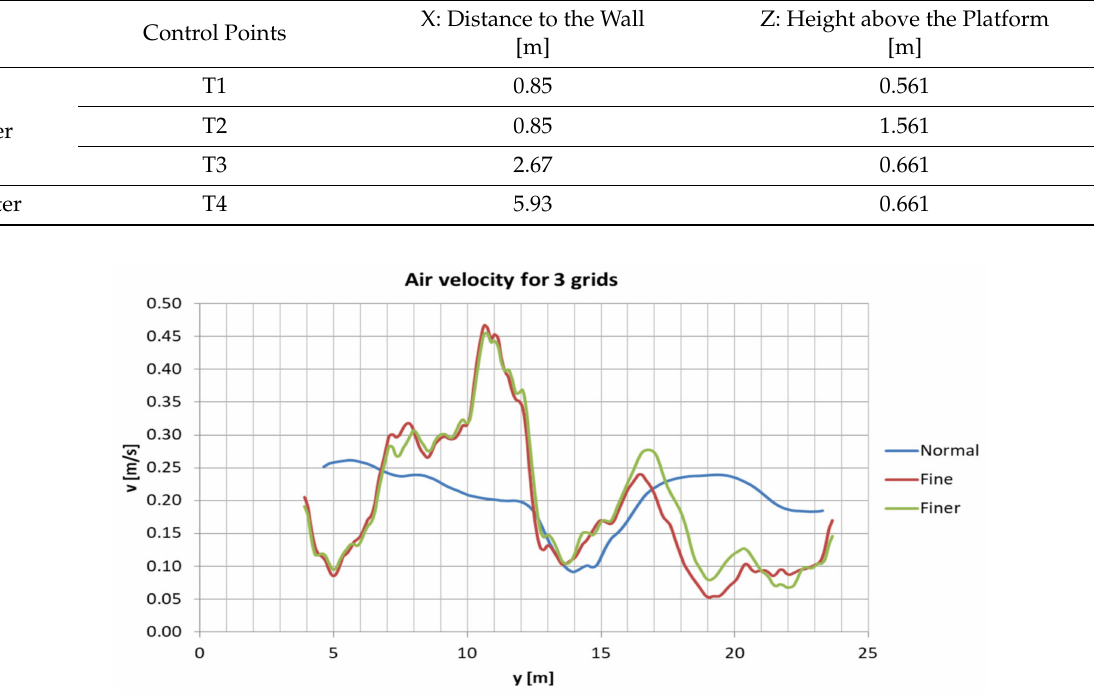
Table 1. Coordinates of the control points.